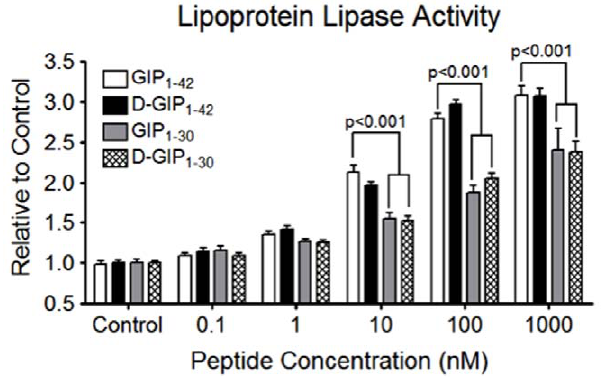
Figure 6. Cultured 3T3-L1 adipocytes differentially respond to D-GIP 1–30 and GIP 1–42 . 3T3-L1 adipocytes were serum starved in 3 mM glucose DMEM containing 0.1% BSA overnight and then treated for 24 h with increasing concentrations (0–1000 nM) of GIP 1–42 , D- GIP 1–42 , GIP 1–30 , or D-GIP 1–30 in the presence of 1 nM insulin and then LPL activity determined. Mean 6 SEM (n=7); significance as